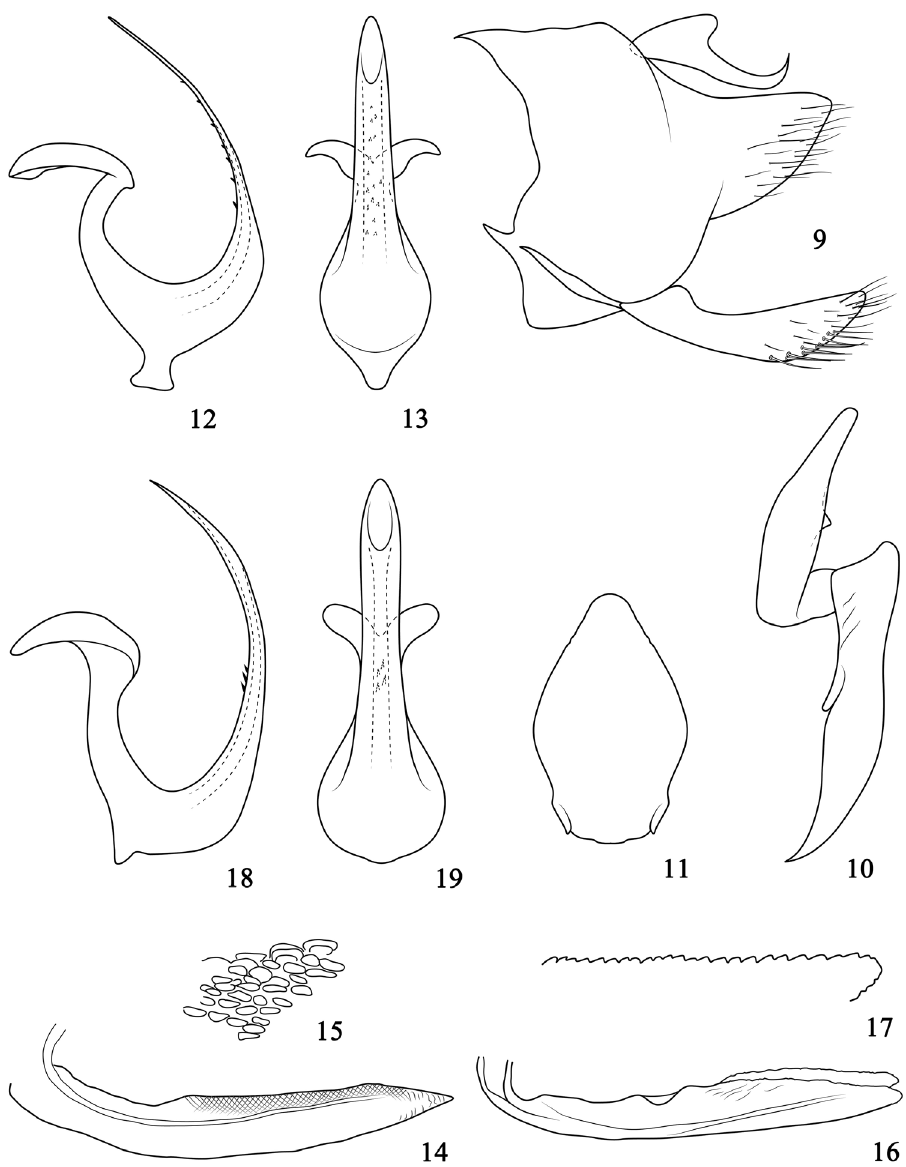
Figures 9–19. Onukigallia species 9–17 O . neoonukii sp. n. 18–19 O . onukii (Matsumura, 1912) 9 Pygofer side and subgenital plate, lateral view 10 Style, dorsal view 11 Connective, dorsal view 12, 18 Aedeagus, lateral view 13, 19 Same, caudal view 14–15 First valvulae 16–17 Second valvulae 15, 17 partial enlarged view. Distribution. China (Sichuan and Guangdong